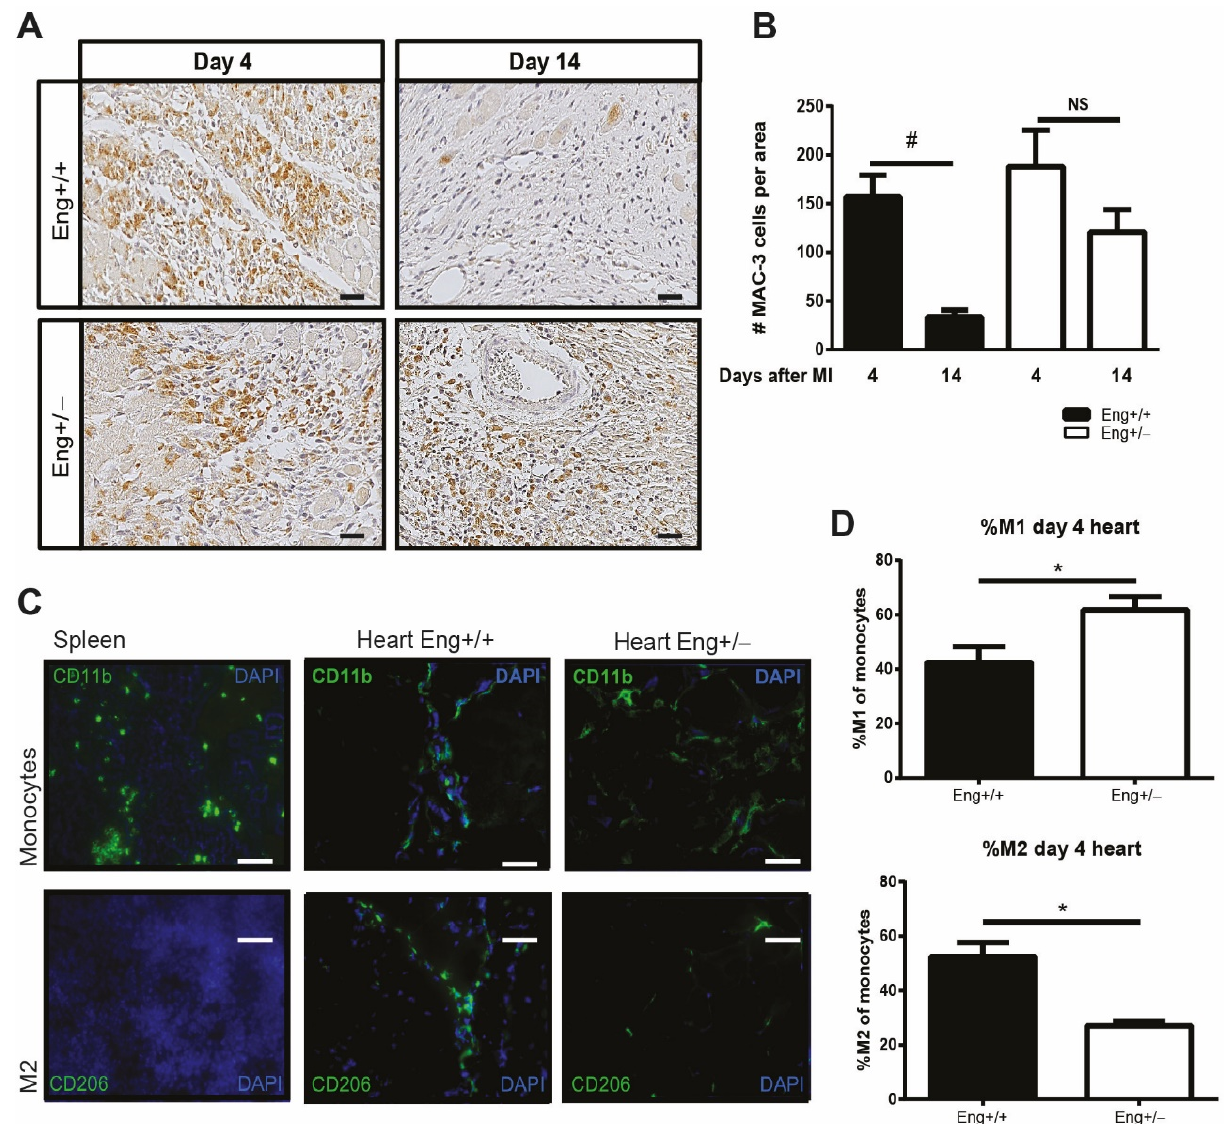
Figure 1. Prolonged macrophage infiltration and decreased number of M2 macrophages after myocardial infarction in Eng+/ − . ( A ) Cardiac sections of Eng+/+ and Eng+/ − mice were stained for MAC-3 expressing macrophage (MAC-3 = brown; nuclei = blue) at day 4 and 14 post MI. Scale bar: 50 µ m. ( B ) Quantification of the MAC3 positive cells shown in an N = 5–16 mice per group. ( C ) Splenic and cardiac tissue post-MI were stained for CD11b (general monocyte marker) and CD206 (M2 macrophage marker) 4 days after MI. Scale bar: 50 µ m. ( D ) The ratio M1/M2 macrophages was determined by flow cytometry using a single cell suspension of Eng+/+ and Eng+/ − mouse hearts 4 days post MI. The inflammatory M1 macrophage was identified by CD11b+/Ly6Chigh/CD206- selection and the regenerative M2 by CD11b+/Ly6Clow/CD206+ selection. N = 5–16 mice per group. Eng+/+ N = 9, Eng+/ − N = 5. * p < 0.05, # p < 0.001, NS: not significant.